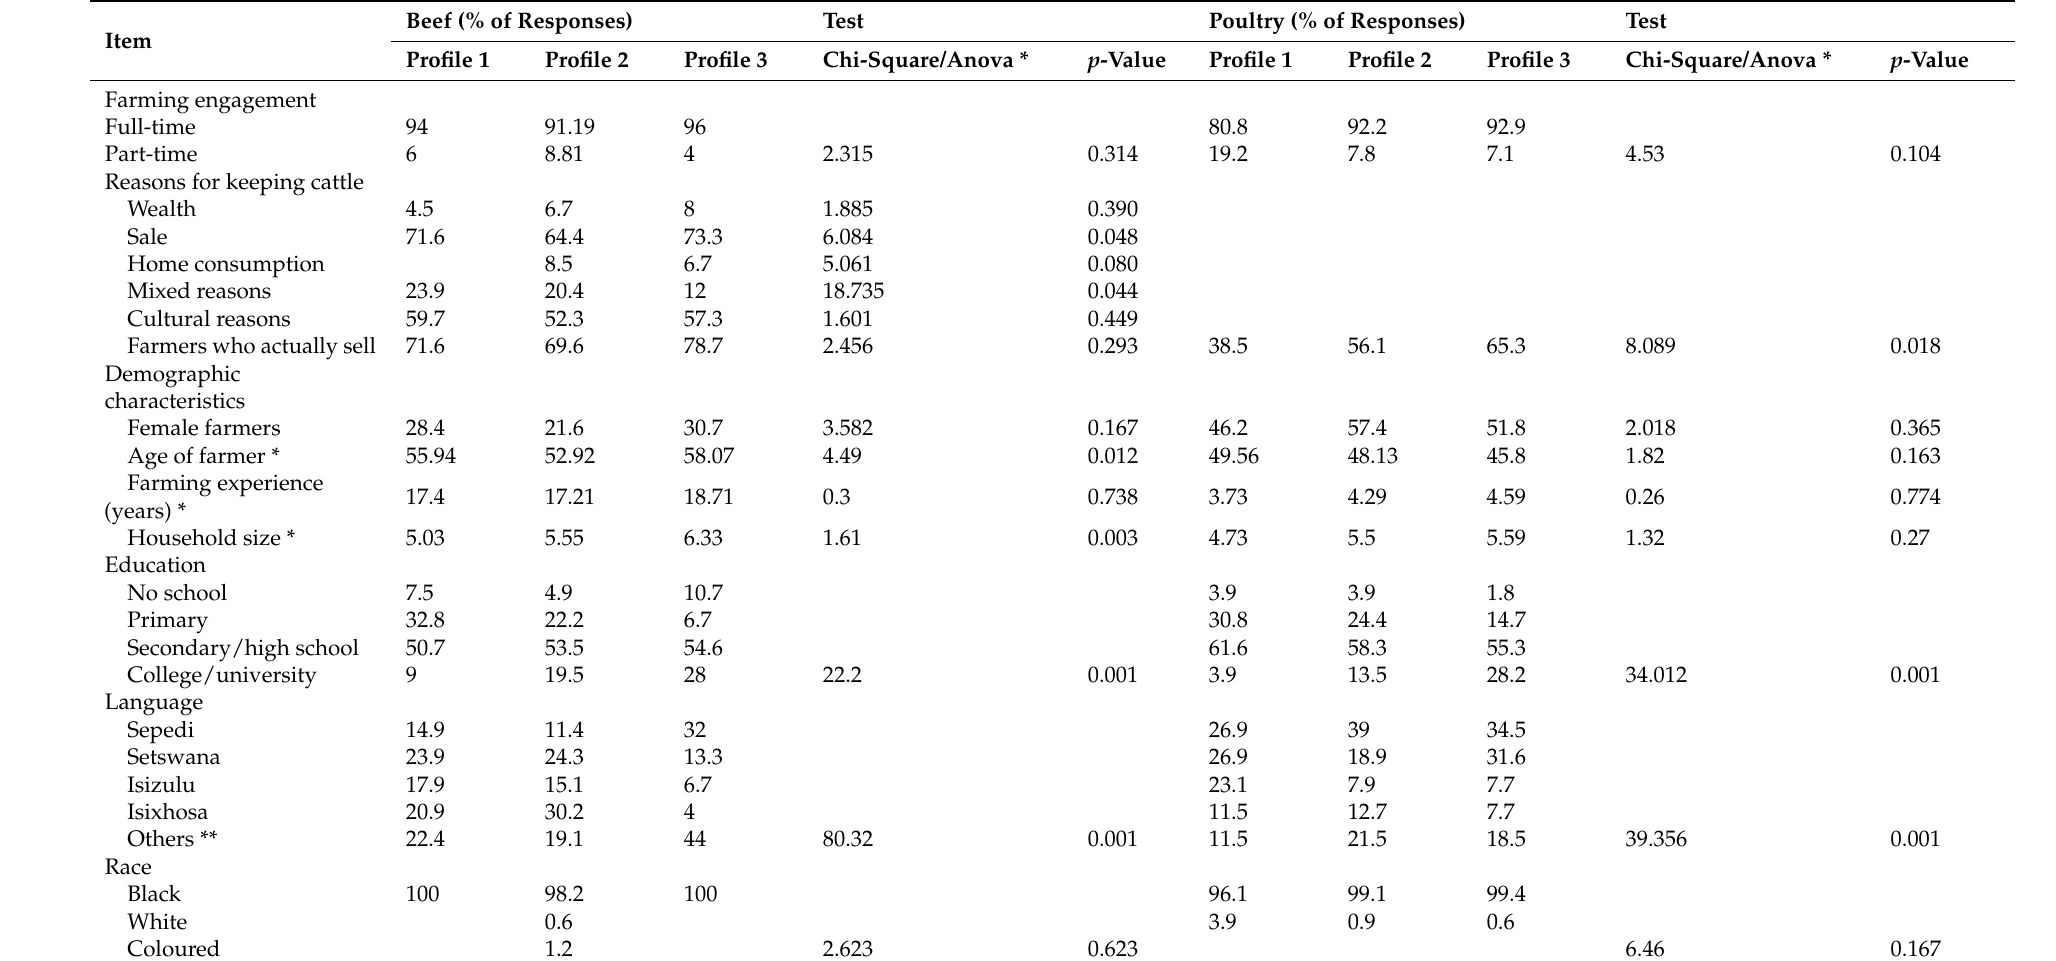
Table 6. Characteristics of beef and poultry farmers by psychological